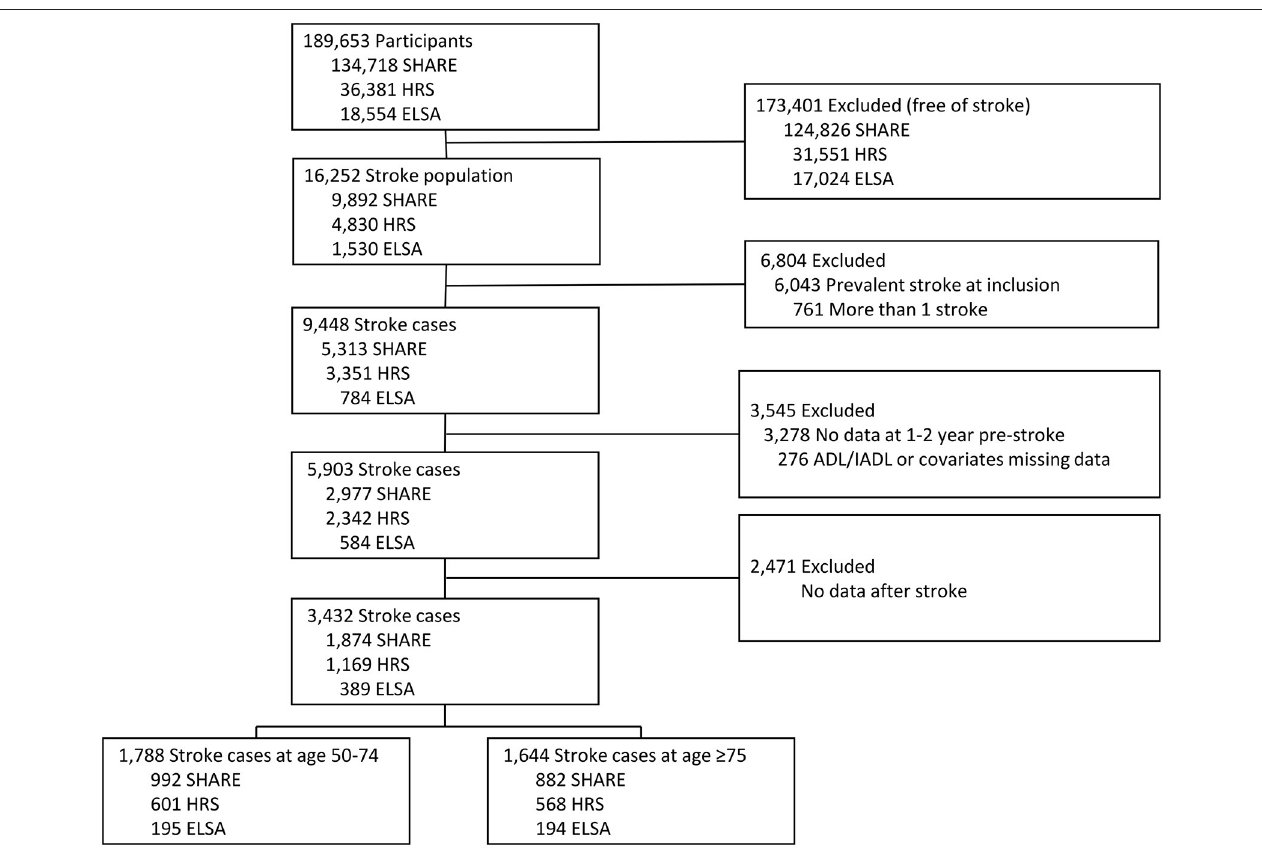
FIGURE 1 | Flowchart of the study